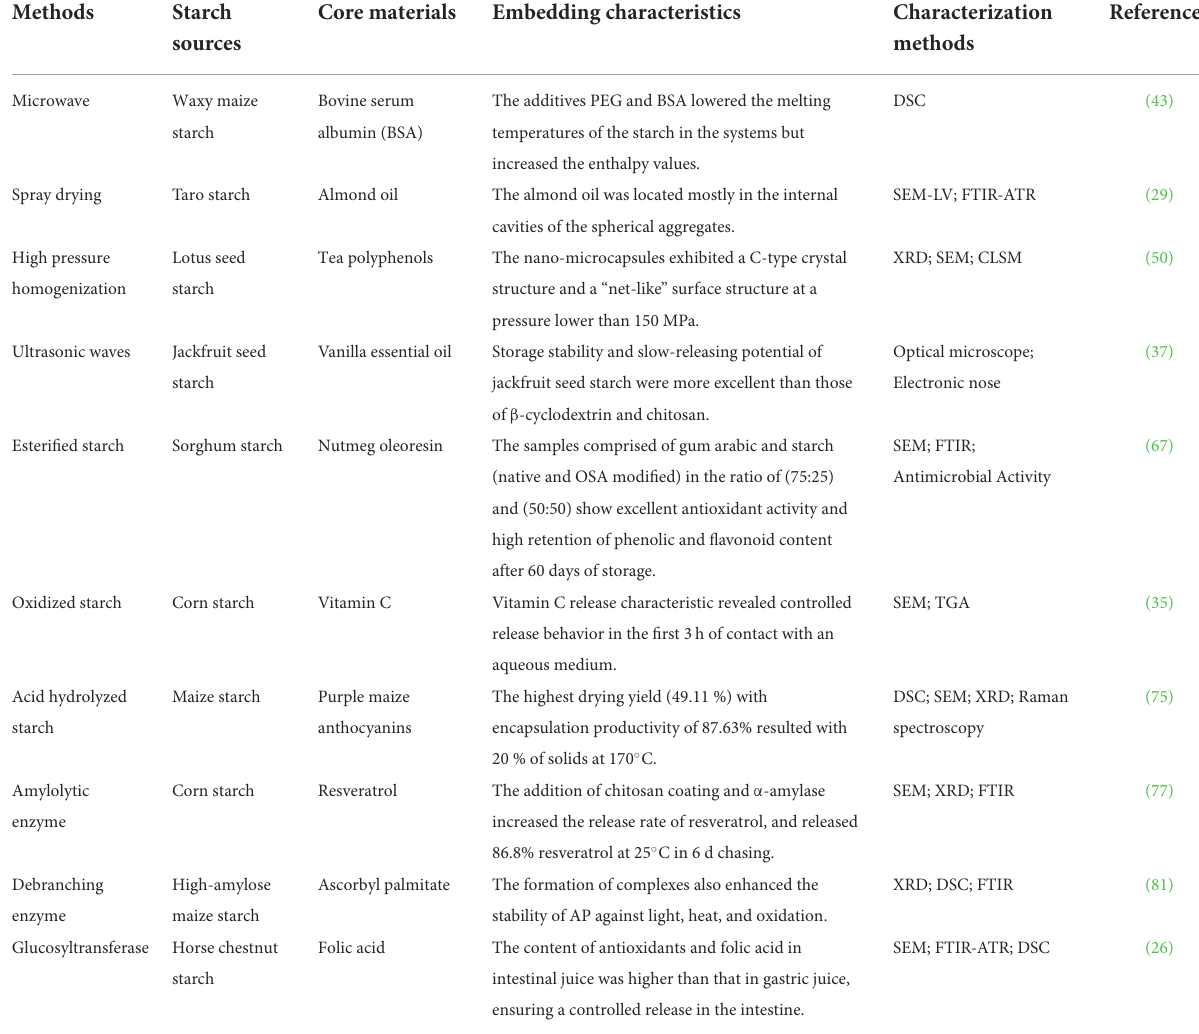
TABLE 2 Embedding characteristics of starch-based nano-microcapsules prepared by different